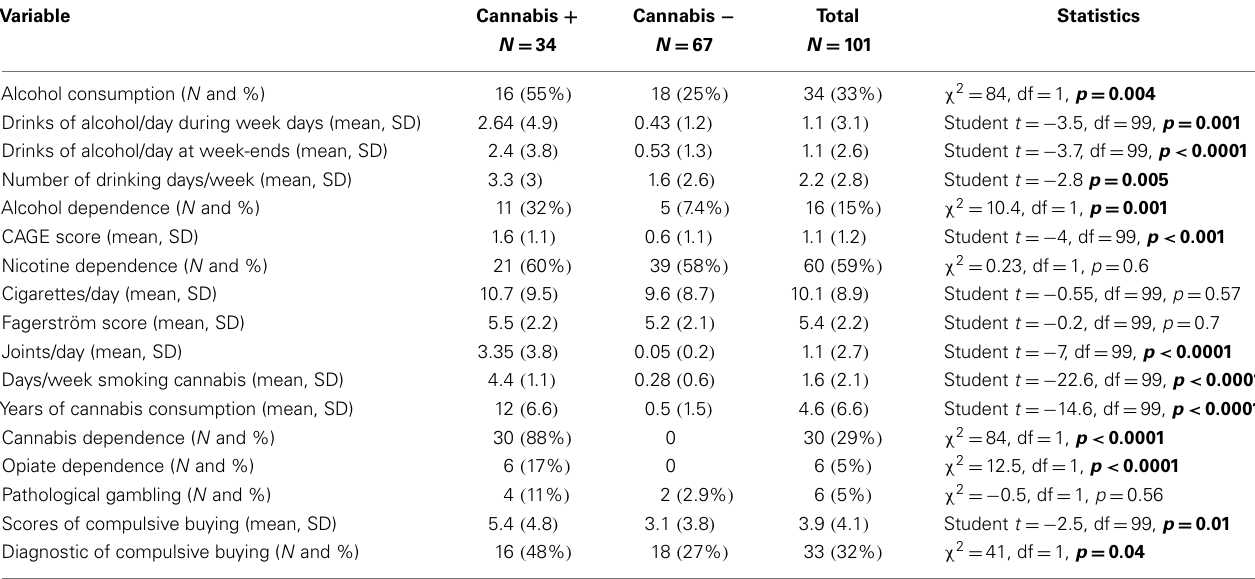
Table 2 | Comparison of addictive disorders among schizophrenic patients with and without cannabis consumption . Variable